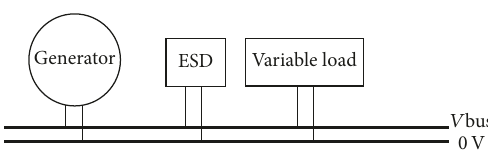
Figure 1: Basic energy management